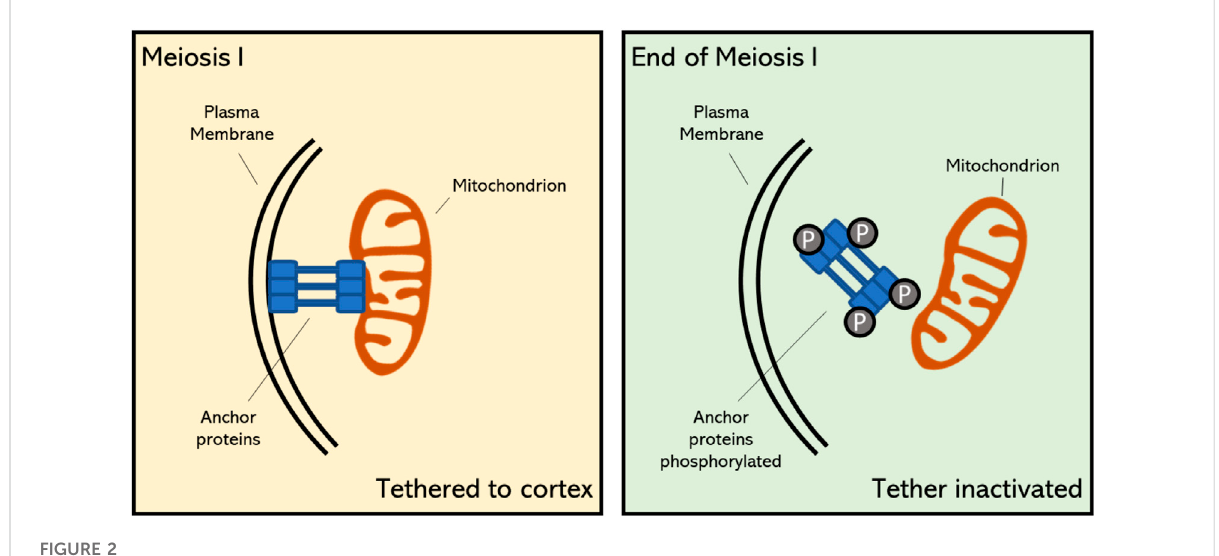
FIGURE 2 Proposedmechanismofmitochondrialtetheringtothecellcortexduringearlystagemeiosisanditsdetachmentatthe fi nalstageofmeiosisIin plants.Thetimelymeiosis-speci fi cdetachmentofmitochondriaiscausedbythedestabilizationofspeci fi canchorproteinsthroughphosphorylation (Sawyer, Joshi et al., 2019). Upon this programmed detachment, mitochondria become positioned in the cellular midzone and contribute to the formation of the organelle